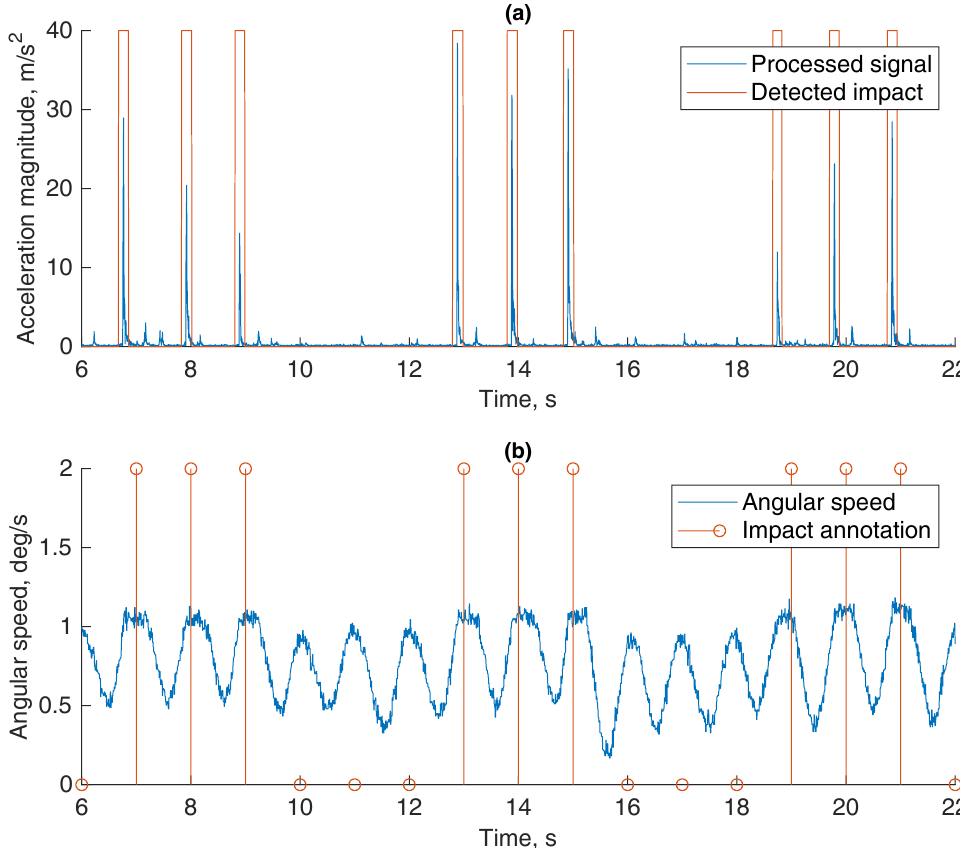
Figure 13. Impact detection in vertical movement. ( a ) Processed accelerometer signal and ( b ) a reference signal of angular velocity with impact